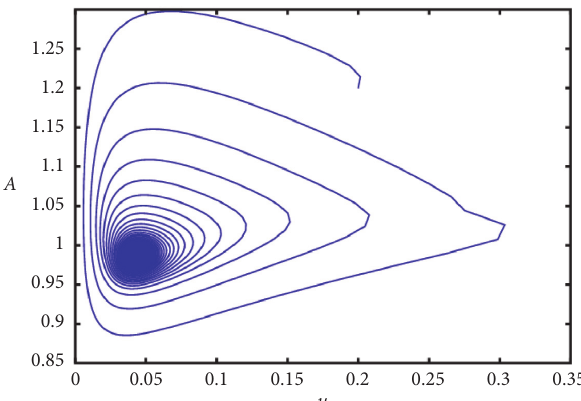
Figure 1: The phase diagram of u − A of system (4) with a � 40, c � 6, λ � 6, r � 0 . 5, b � 1, d m � 0 . 02. It describes the asymptotic stability of the equilibrium ( 0 . 0433 , 0 . 0774 , 0 . 9868 ) .